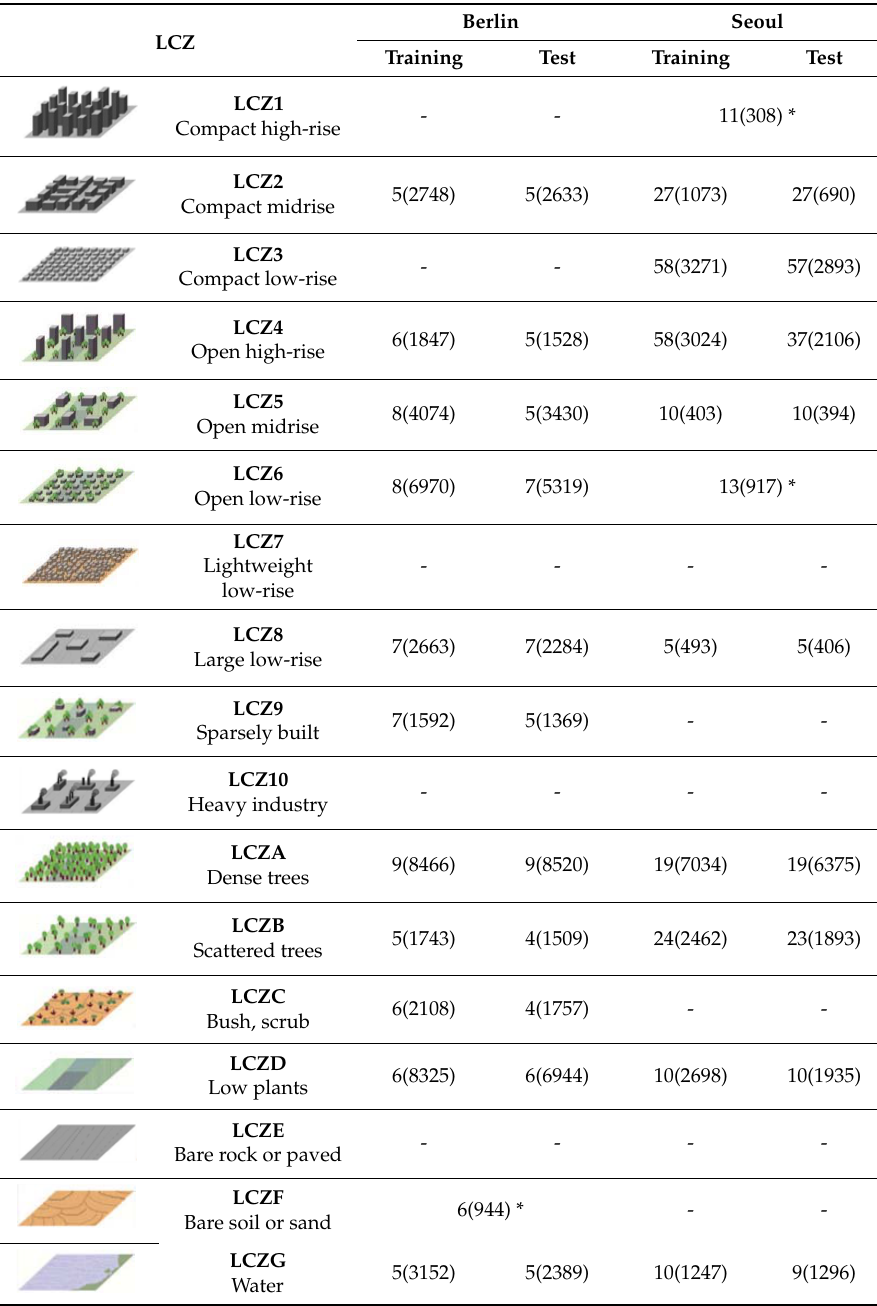
Table 1. Training and test datasets of each LCZ type for Berlin and Seoul. The values in the training and test columns represent the number of polygons. The number of the corresponding pixels (50 m resolution) is shown in parentheses. * is assigned to the red-star classes, which have only a few reference polygons of the LCZ classes. The LCZ figures in the first column are reused from Stewart and Oke [13].